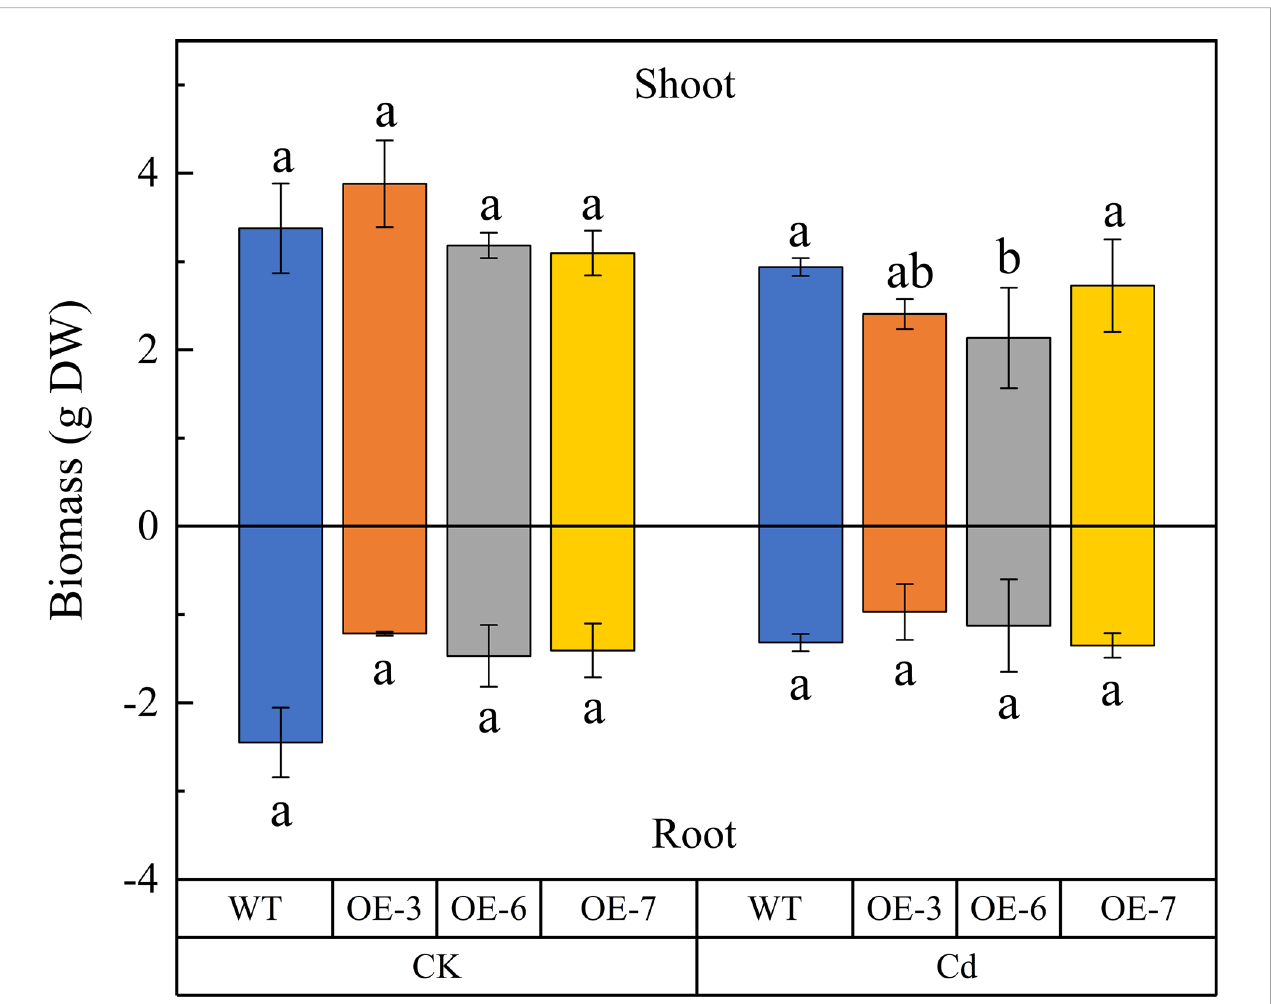
FIGURE 1 Effect of cadmium (Cd) stress on the shoot and root biomasses of SpCTP3 -overexpressing transgenic and WT lines. Data are presented as the mean ± SD of three independent replicates. Different letters above bars indicate signi fi cant differences among treatments ( p < 0.05; n =